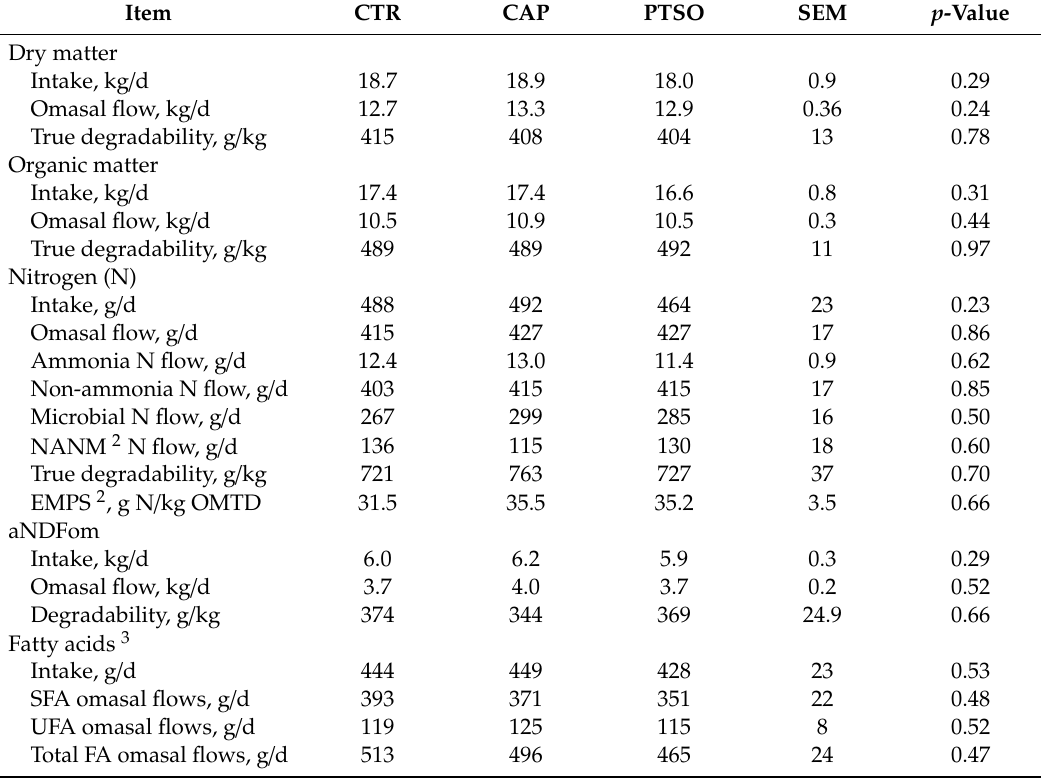
Table 4. E ff ect of propyl-propane thiosulfonate and capsicum oleoresin addition on intake, flows at the omasal canal, and ruminal degradability of dairy cows (n = 3) 1 .